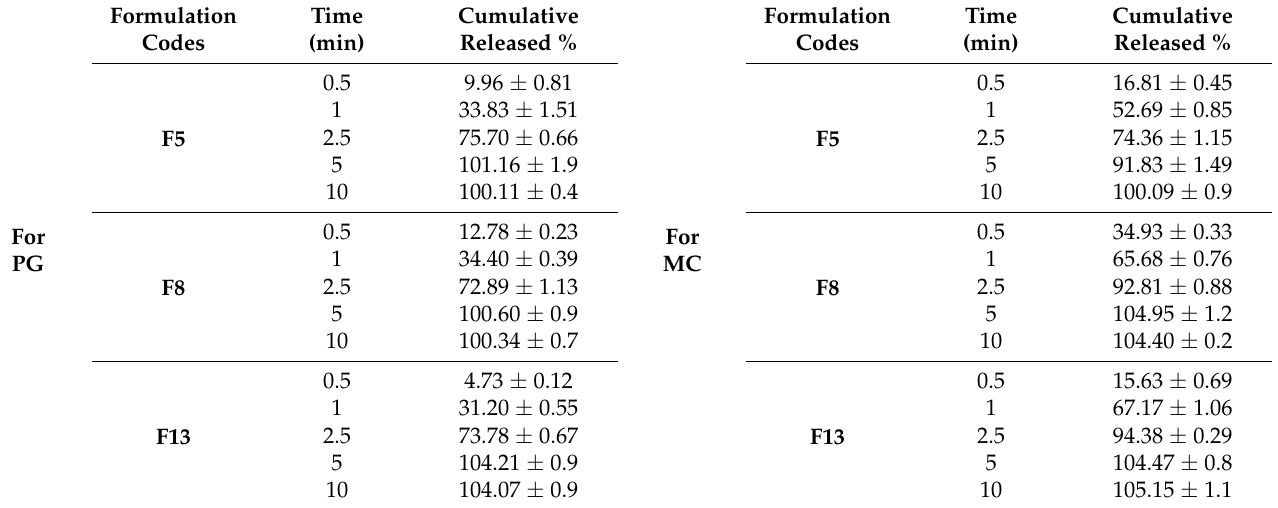
Figure 3. Blank OTFs ( left ), PG and MC included OTF ( right ). Table 7. Dissolution rate results of OTFs ( n = 3, Table 3. PG and MC recovery % data after 72 h ( Ⴟ ± SD).